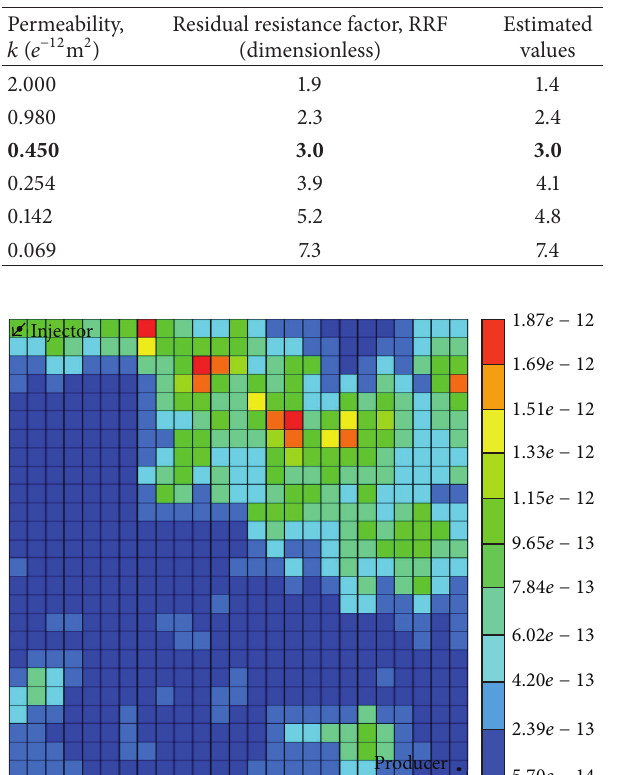
Table3:Observationandestimationoftheresidualresistancefactor (RRF) at various permeabilities.